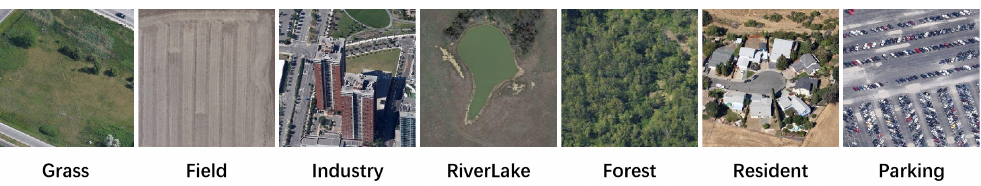
Figure 3. RSSCN7 dataset. The RSSCN7 dataset contains 7 classes of images, each class contain 400 images. Some of the images are shown in the